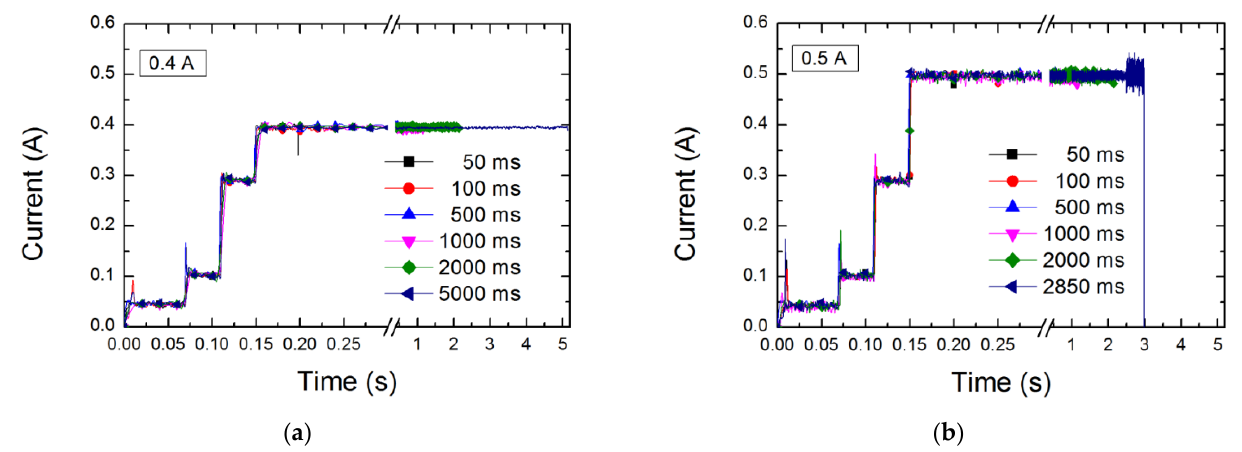
Figure 4. Stepwise current supply versus time plot with ( a ) the 0.4 A final-step current and ( b ) the 0.5 A final-step current.